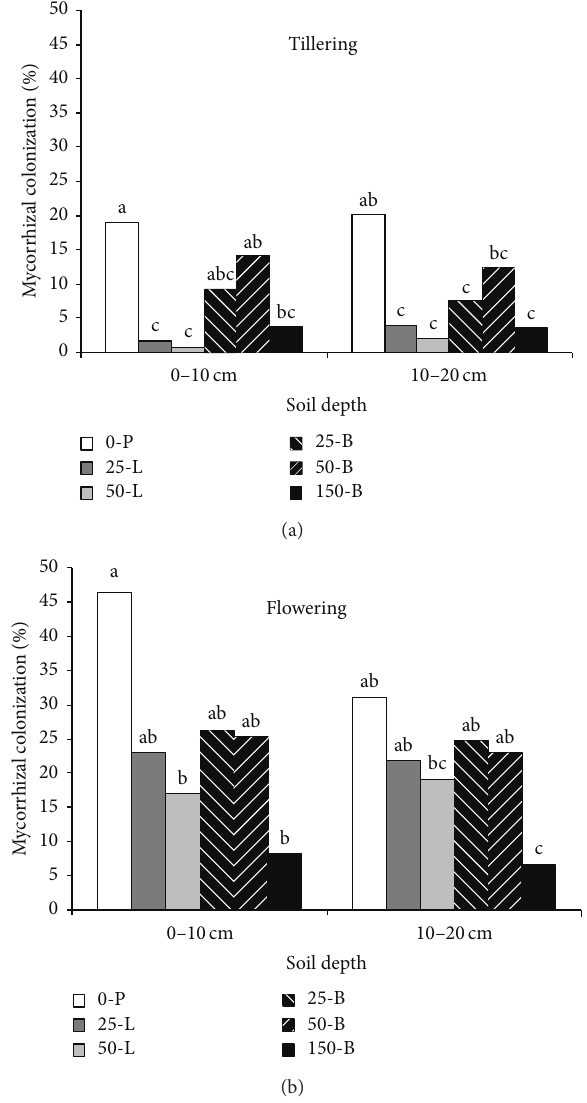
Figure 6: Indigenous mycorrhizal colonization of wheat roots at the Necochea site as affected by P fertilization and soil depth. Means followed by the same letter are not significantly different from each other based on the LSD test (0.05). P-B; phosphorus broadcasted. P-L: phosphorus banded at